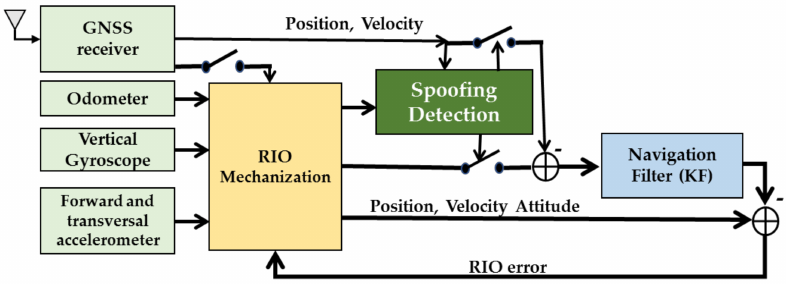
Figure 2. Loosely coupled RIO mechanization for spoofing